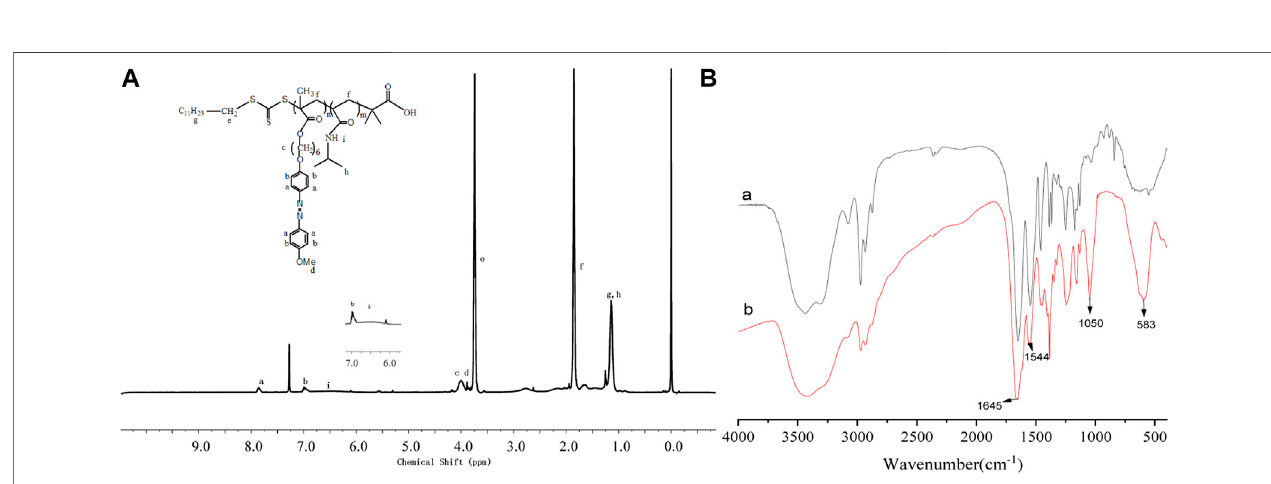
FIGURE 3 | 1 HNMR spectra of PNIPAM-b-PAzoMA (A) , FT-IR spectra of PNIPAM-b-PAzoMA, and Fe 3 O 4 @PNIPAM-b-PAzoMA nanoparticles (B) .